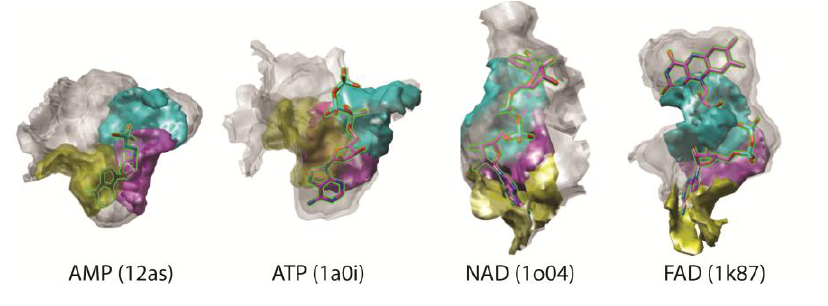
Figure 7. Examples of matching patch pairs in AMP, ATP, NAD and FAD binding pocket using the distance threshold 0.30. The matched pairs which locate at equivalent position to adenosine monophosphate are shown in the same color.